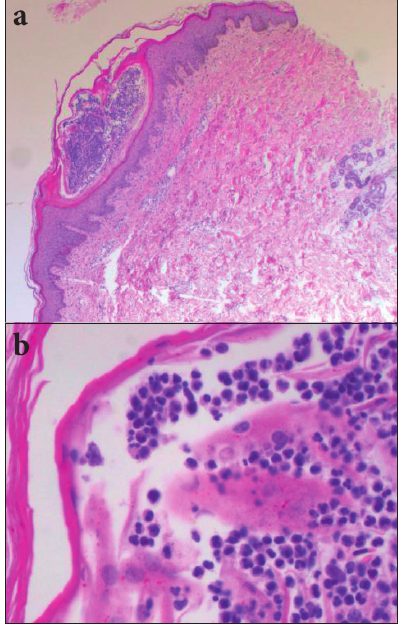
Fig. 2. (a) Intracorneal pustule (x20) containing (b) neutrophils and occasional lymphocytes (x200).